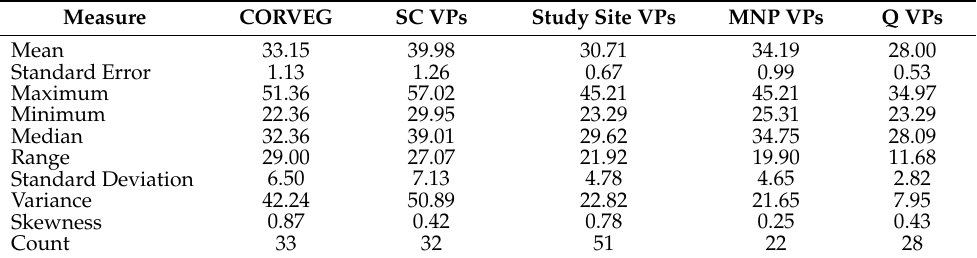
Figure 7. Canopy height variations for the Sunshine Coast intra-subregional study area. The study site, with 50 virtual plots, shows similar distribution to CORVEG as a whole, but Quinlans (Q) is substantially lower than CORVEG, and all the datasets are lower than the 32 Sunshine Coast random virtual plots. Table 10. Regional CORVEG virtual plots (VPs) and subregional Sunshine Coast VP canopy heights compared to the Sunshine Coast intra-subregional study site. Quinlans (Q) has a lower canopy characterised by a lower standard deviation and low variance.